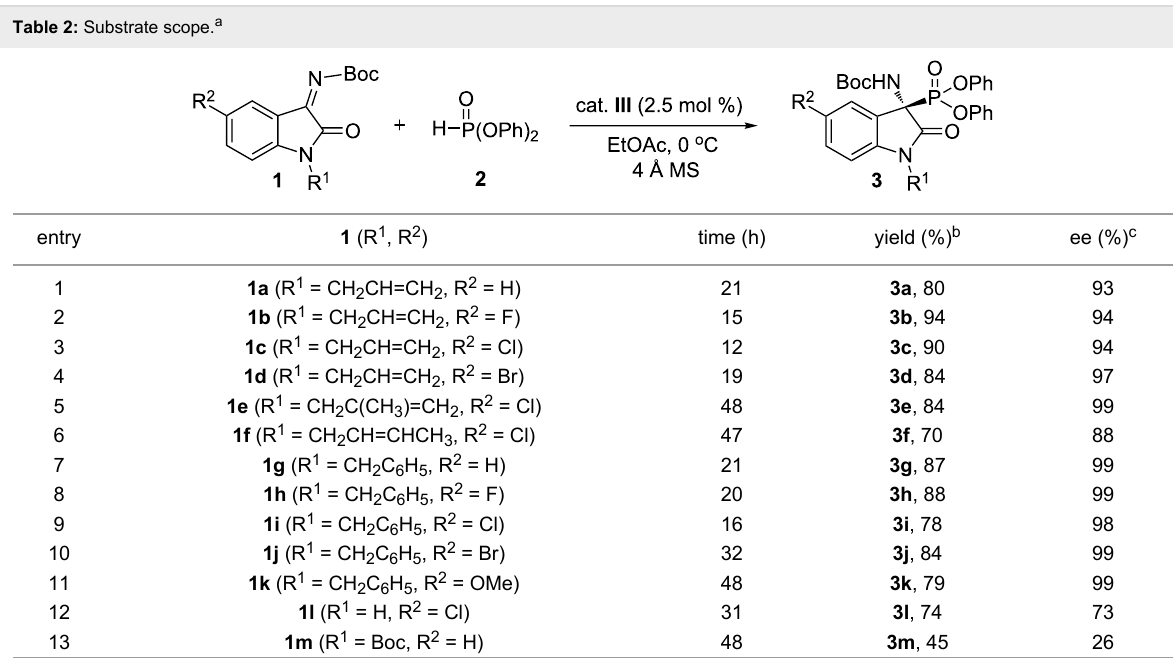
Table 2: Substrate scope. a